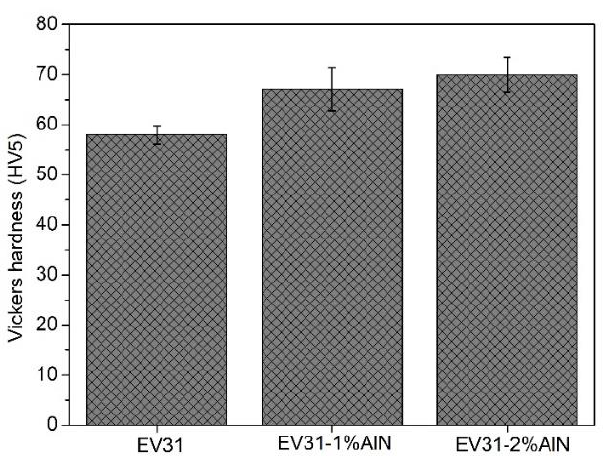
Figure 5. Vickers hardness of as-cast modified EV31, modified EV31-1%AlN and modified EV31- 2%AlN.